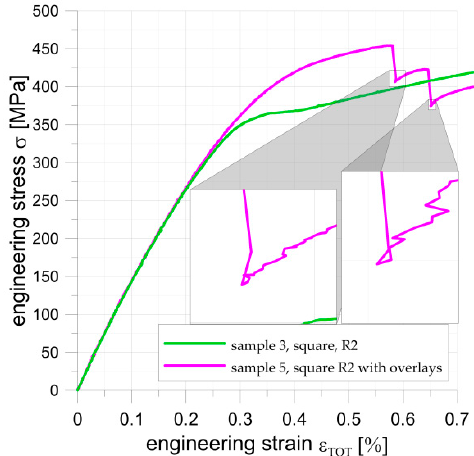
Figure 15. Comparison of engineering stress–strain curve metal sample 3 and sample 5 with composite overlays with square holes with fillet radii R2.